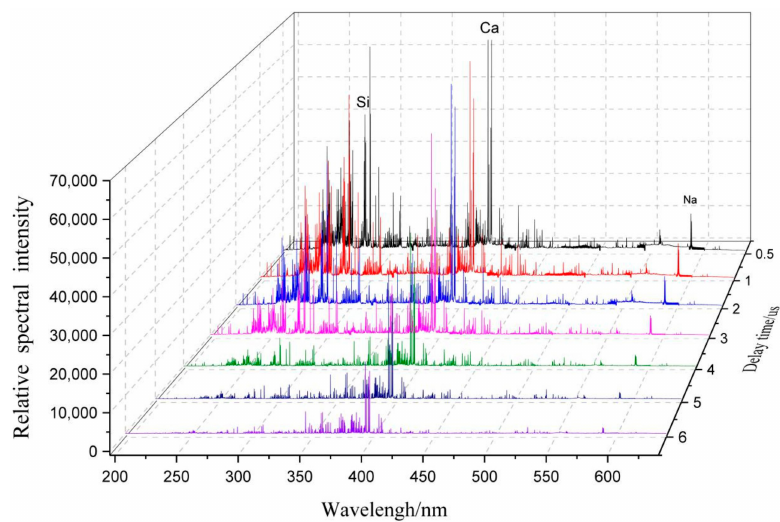
Figure 7. Changes in LIBS spectra within a certain band range with delay time.